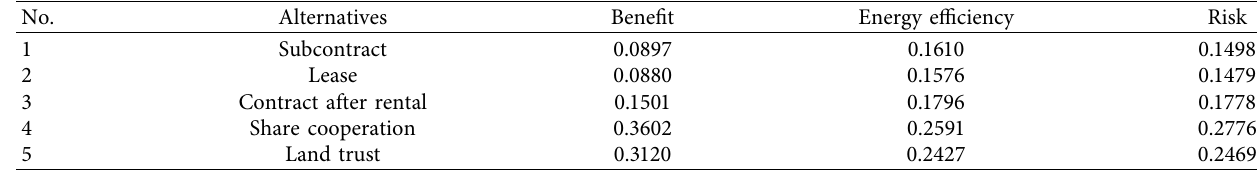
Table 6: Scores’ list in each model criteria layer of the rural land circulation mode performance evaluation.